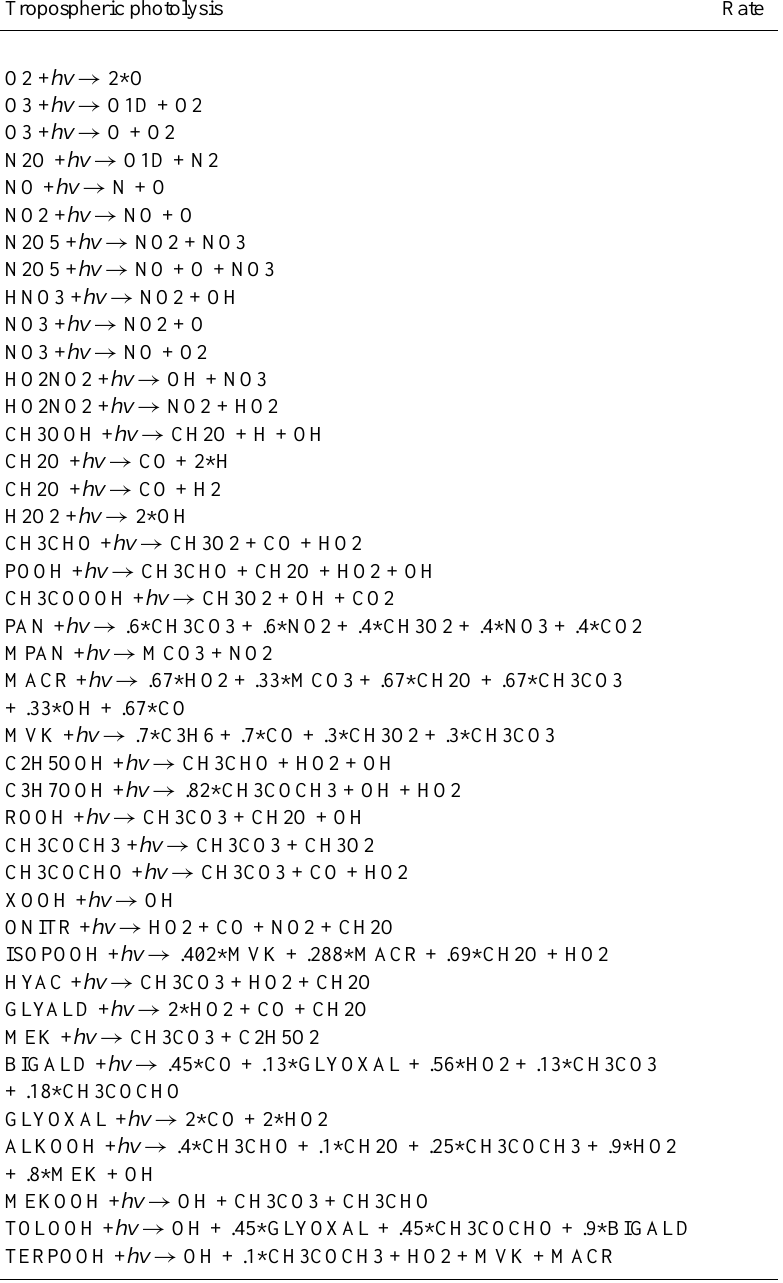
Table 4. List of reactions. Temperature ( T ) is expressed in K, pressure ( P ) in Pa, air density ( M ) in moleccm − 3 , ki and ko in cm 3 molec − 1 s − 1